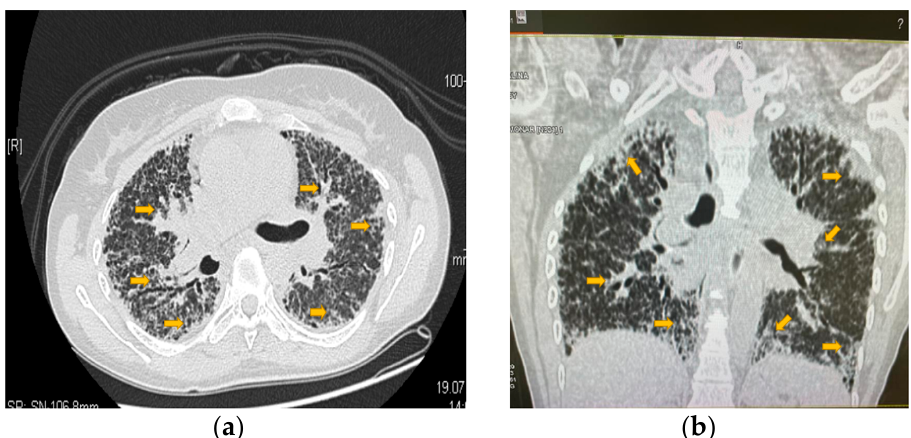
Figure 5. Highly accentuated bilaterally symmetric reticulo-micronodular peri broncho vascular interstitium with marked thickening of the interlobular septa and ground-glass images in the context of pulmonary lymphangitis and extensive pulmonary fibrosis changes. ( a ): Section in the floor of the pulmonary hilum; ( b ): reconstruction through the floor of the pulmonary hilum. Yellow arrows indicate the problem areas. (Computed tomography scan of the lungs from the archive of the first author).